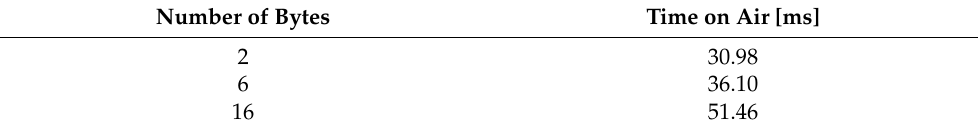
Figure 8. The proposed Short LoRaWAN packet structure. Table 5. Time On Air for 869.850 MHz, modulation frequency 125 kHz and spreading factor